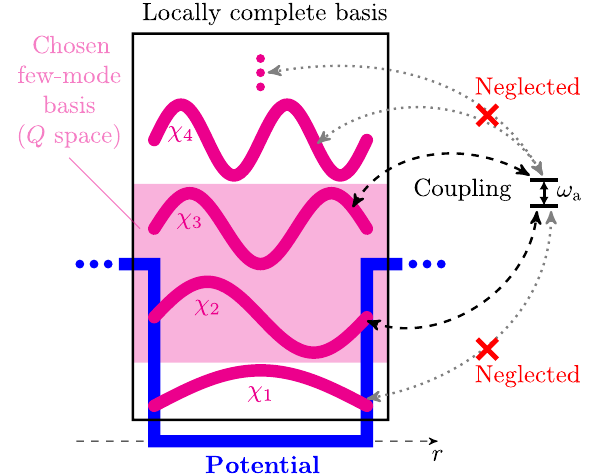
FIG. 2. Schematic illustrating the part of the paper on interact- ing systems, in particular, the few-mode approximation and constructive approach to choosing few-mode bases for an ab initio effective few-mode expansion. After introducing system modes and bath modes (see also Fig. 1), the few-mode approximation consists of neglecting the interaction of the interacting subsystem (e.g., a two-level atom located inside the cavity with transition frequency ω ) with the bath modes. In the figure, an example of a a two-mode basis is shown as the states inside the magenta shaded box. Ideally, the set of system modes is chosen exploiting physical insight into the system under study, to facilitate the modeling of the system with as few modes as possible. In the absence of any prior knowledge, a constructive approach can be used to determine a few-mode basis. For this approach, a locally complete basis (states inside the black box) is found as solutions to the Dirichlet boundary value problem in the potential region, which, in general, contains infinitely many modes. A few-mode basis is then given by a subset of the locally complete basis. Varying the number of modes in the few-mode basis and performing the few-mode approximation in each case yields a systematic expansion